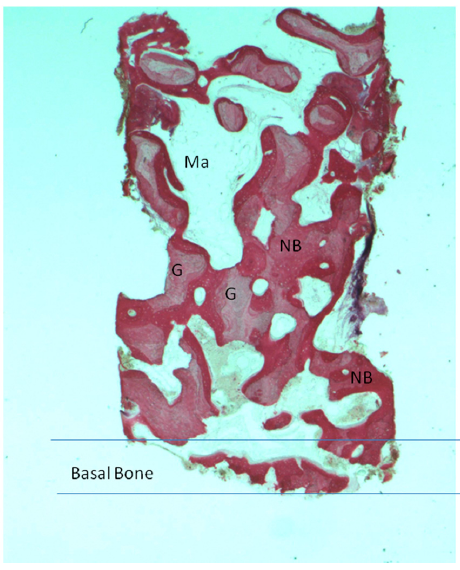
Figure 4. Group I. New bone extended from the basal bone of sinus. The graft (G) was surrounded by new bone (NB). A large madullary space was present (Ma). Acid fuchsin and toluidine blue 4X (X represents the power magnification of microscopical image.)